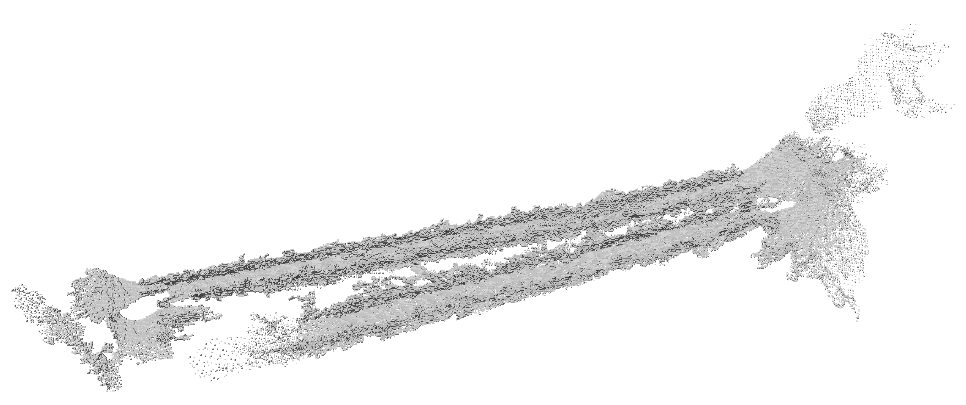
Figure 11. Resulting octree of the conversion from point cloud data.